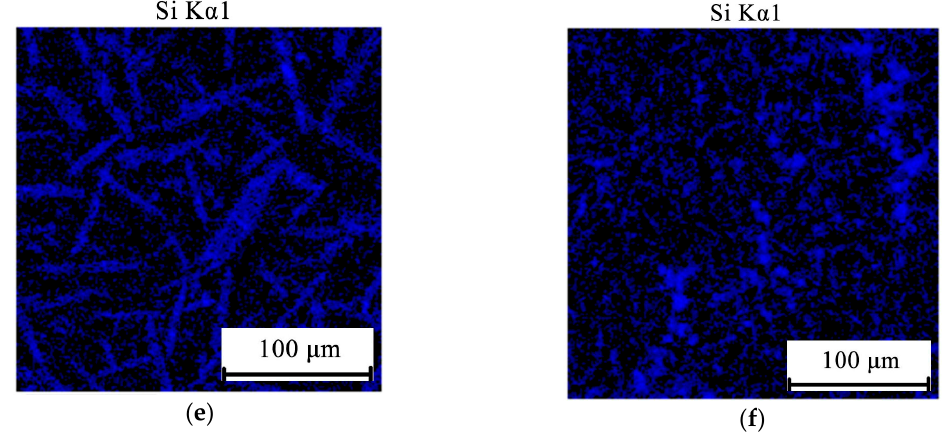
Figure 7. Electron microprobe analysis (EMPA) elemental mapping of Ca ( a , b ), Mg ( c , d ), and Si ( e , f ) in hyper-eutectic alloys Al10Mg10Ca2Si ( a , c , e ) and Al10Mg4Ca2Si ( b , d , f ).